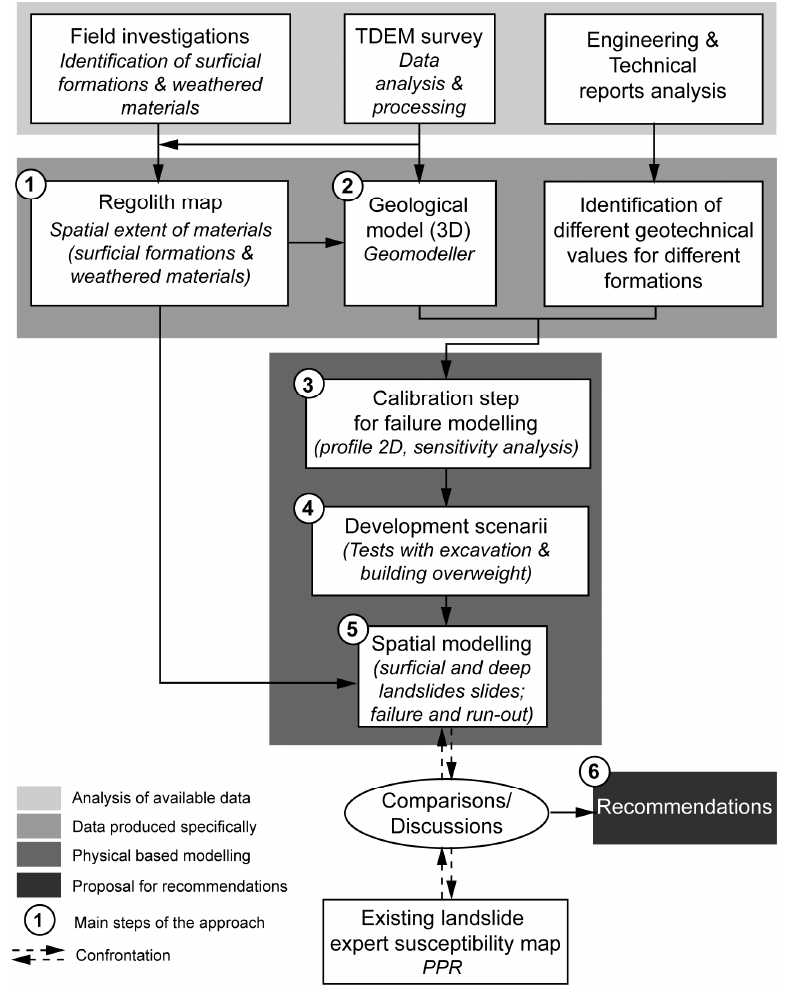
Figure 4. General methodology flow chart.